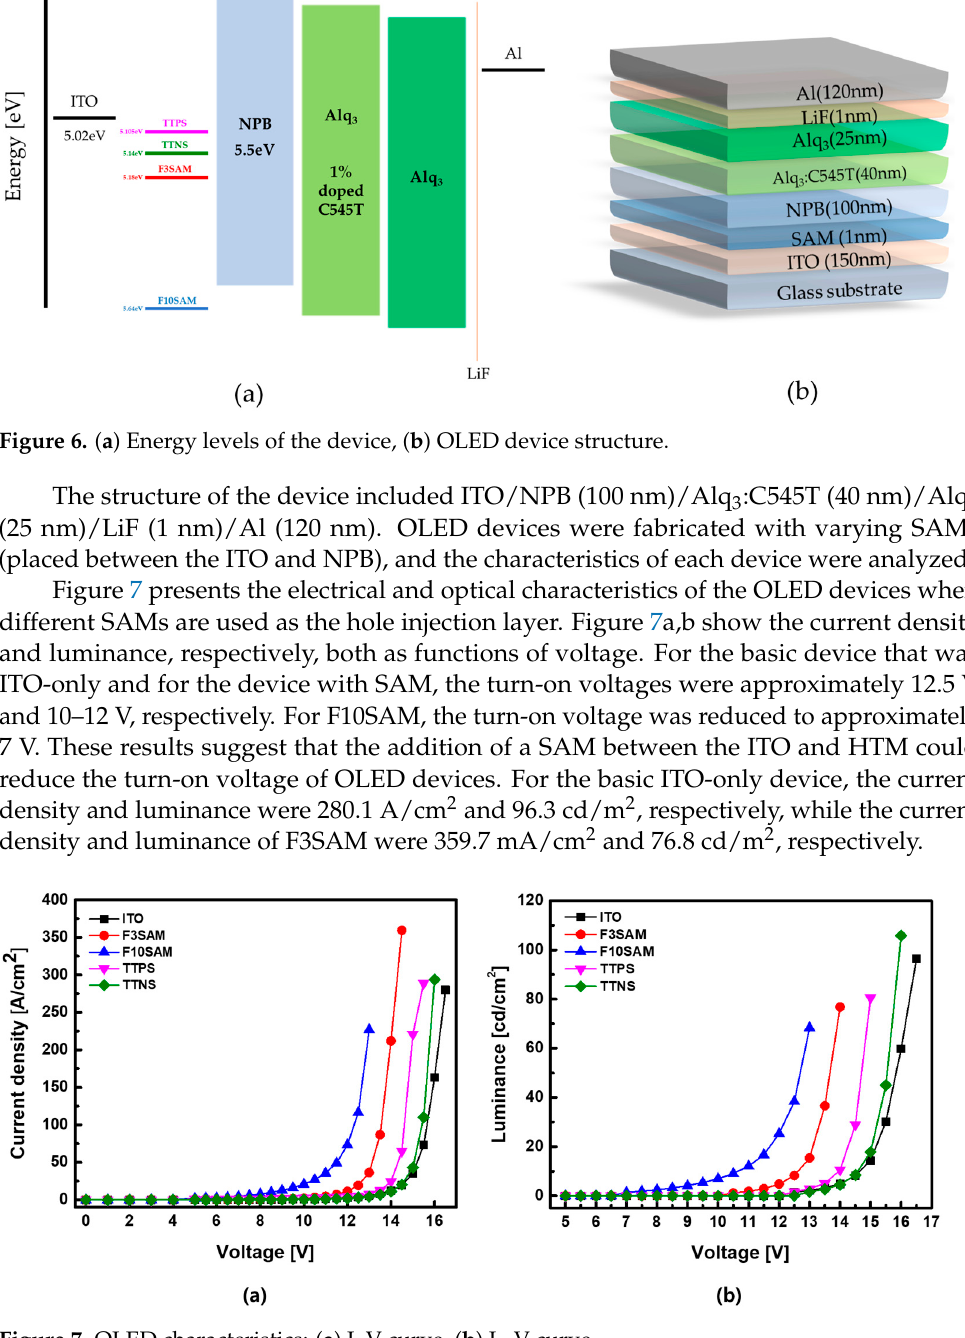
Figure 7. OLED characteristics: ( a ) J–V curve, ( b ) L–V curve.